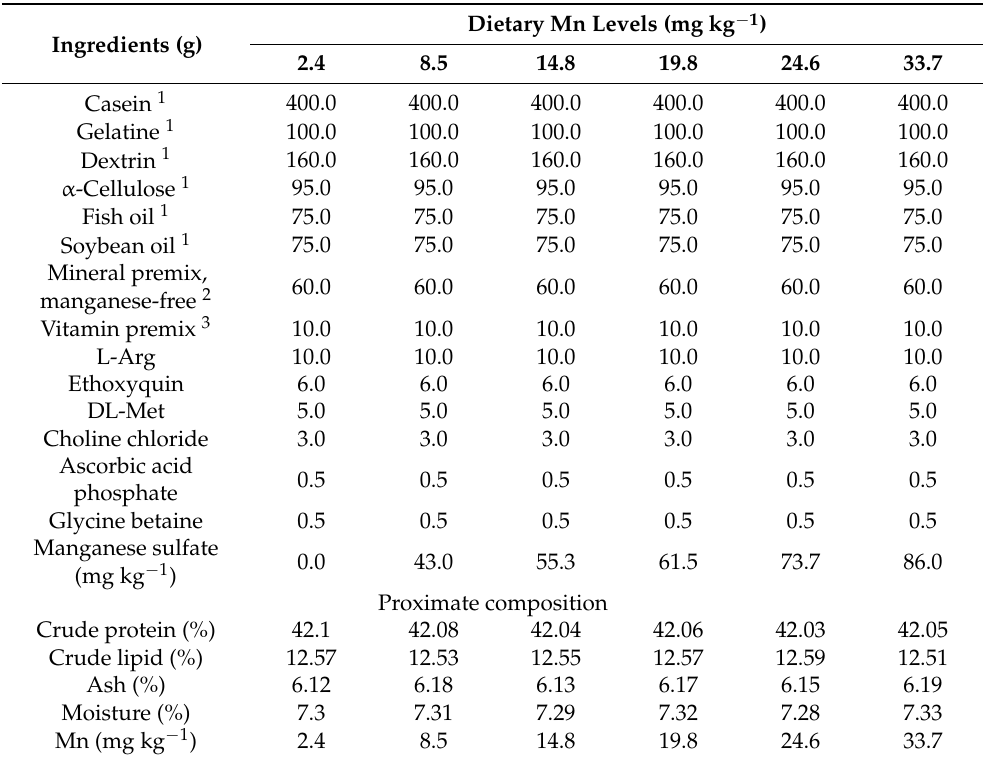
Table 1. Formulation and proximate composition of diets for post-larval coho salmon Oncorhynchus kisutch (g kg − 1 dry